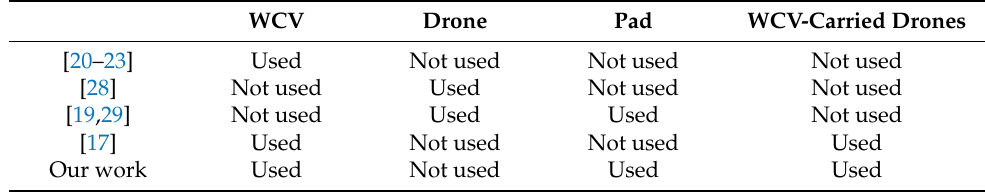
Table 1. Comparison with related